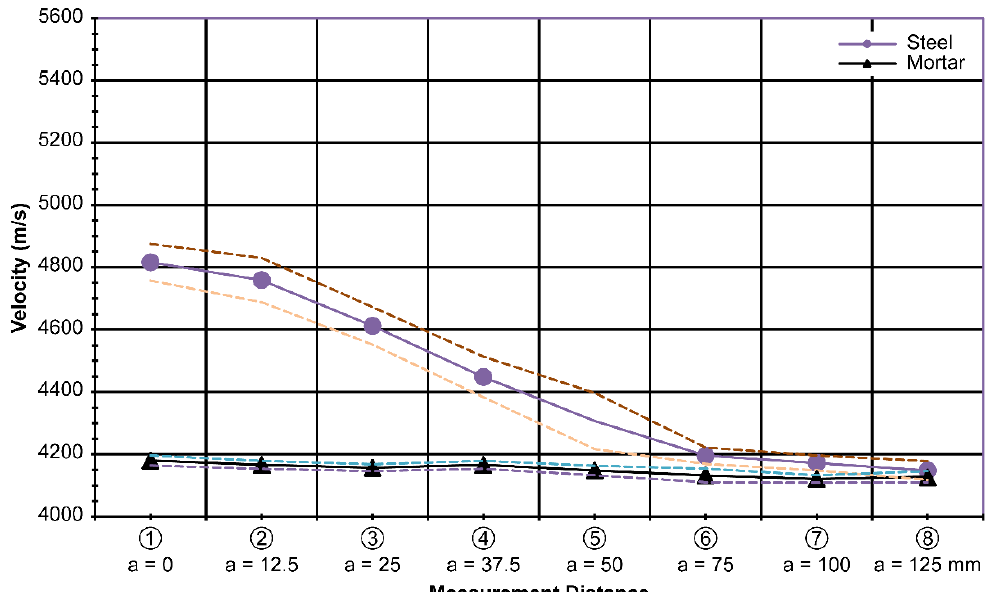
Figure 8. Combined measurement data with steel thickness (t)variation at d =75 mm and h = 150 mm. Figure 8 combines all of the measurement results for varying thicknesses(t). The standard